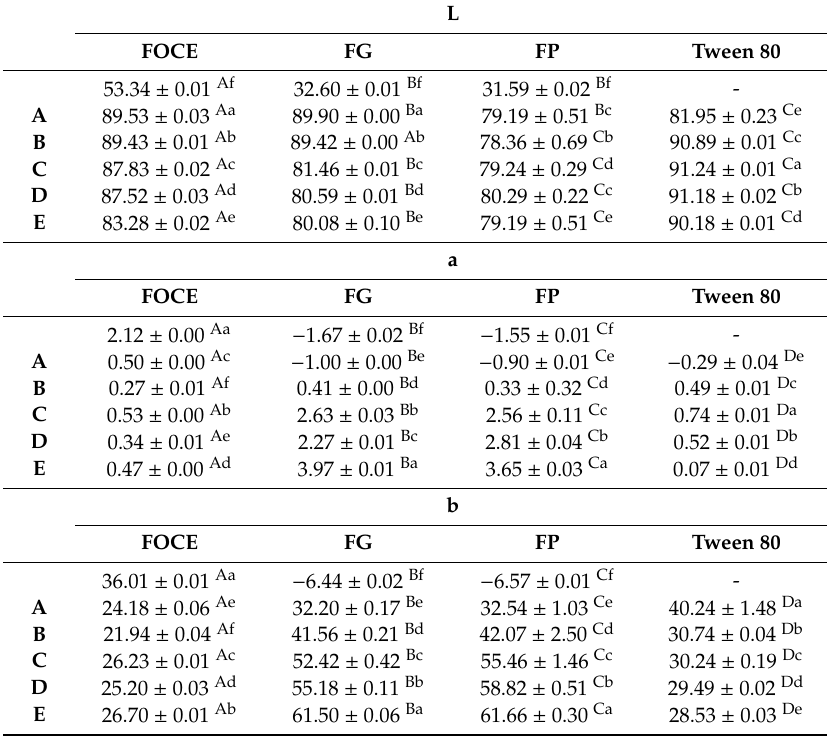
Table 4. Color values of emulsions prepared with various content of flaxseed